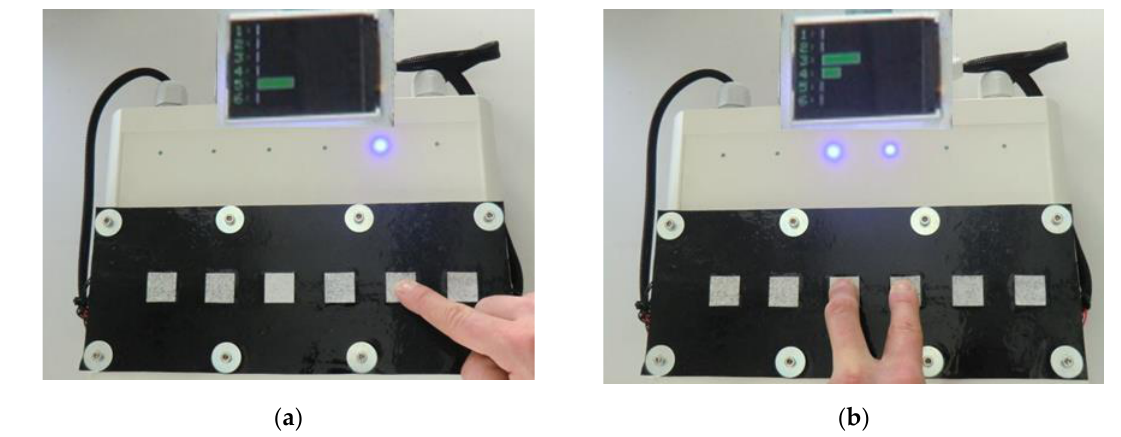
Figure 21. Human – machine interface: a flat panel with six pressure sensors visible as white fields, six corresponding LEDs and a display that illustrates the finger pressure as green bars. Operation with one finger ( a ) and with two fingers ( b ) [103].